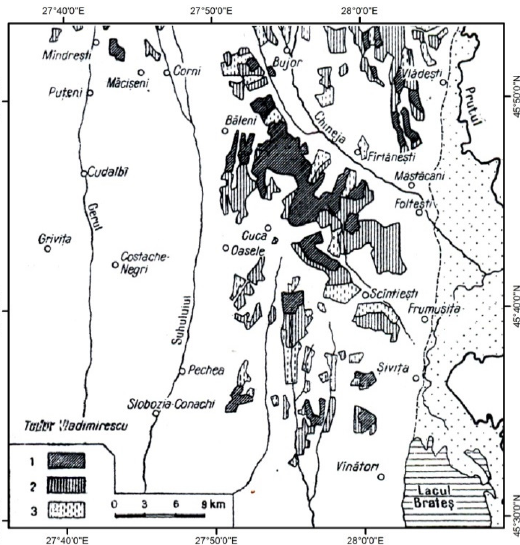
Figure 9. Shrinkage of forest areas during 1893–1938 [68]. Legend: 1. Forests in 1938; 2. Forests in 1893; 3. Deforested areas in the last 19th-century decades.